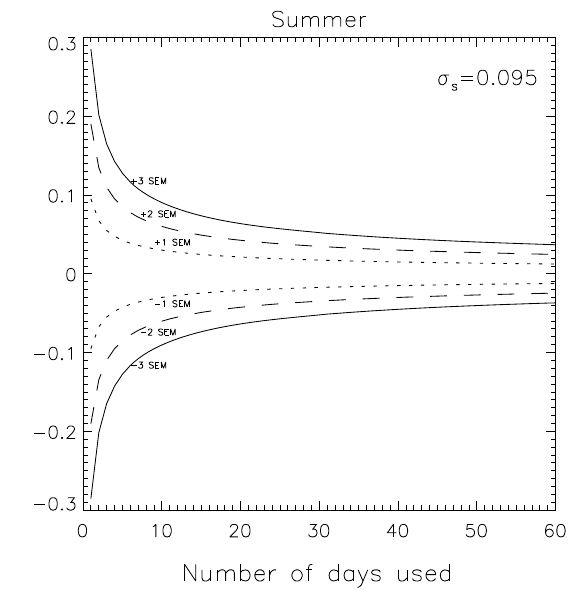
Fig. 10. Standard error of the mean of the total correction factor (SEM) versus the number of days ( n ). The curves ( ± 1 SEM, ± 2 SEM, ± 3 SEM) were calculated as sample standard deviation σ s (i.e. ± 1 σ s , ± 2 σ s , ± 3 σ s ) divided by square root of n . (Analysis based on summer data